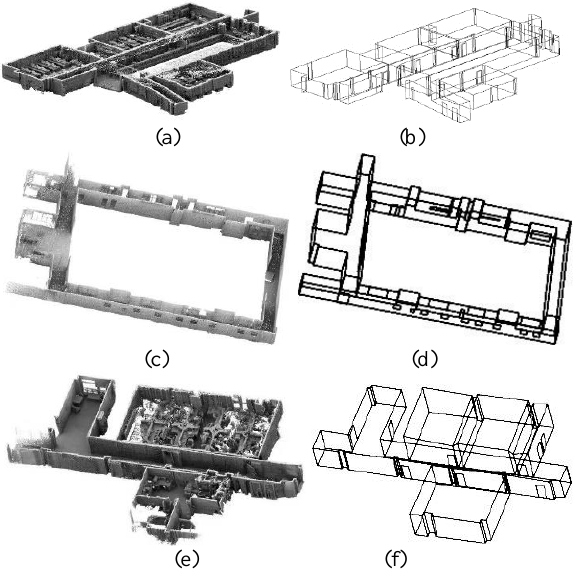
Figure 3. Illustration of BIM feature extraction dataset.